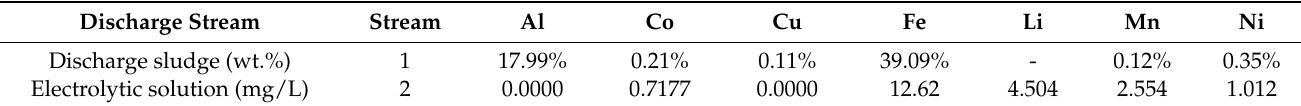
Table 2. Average discharge sludge and electrolytic solution metal Table 1. Percentage of metals in the feed reporting to the LIB discharging side streams.